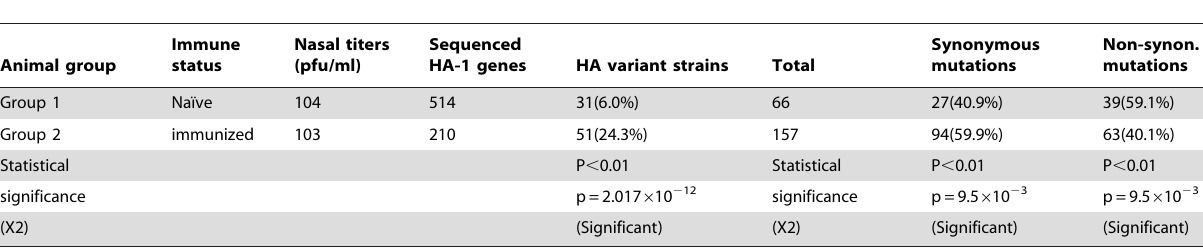
Table 1. Sequence analysis of progeny virus from influenza infection of guinea